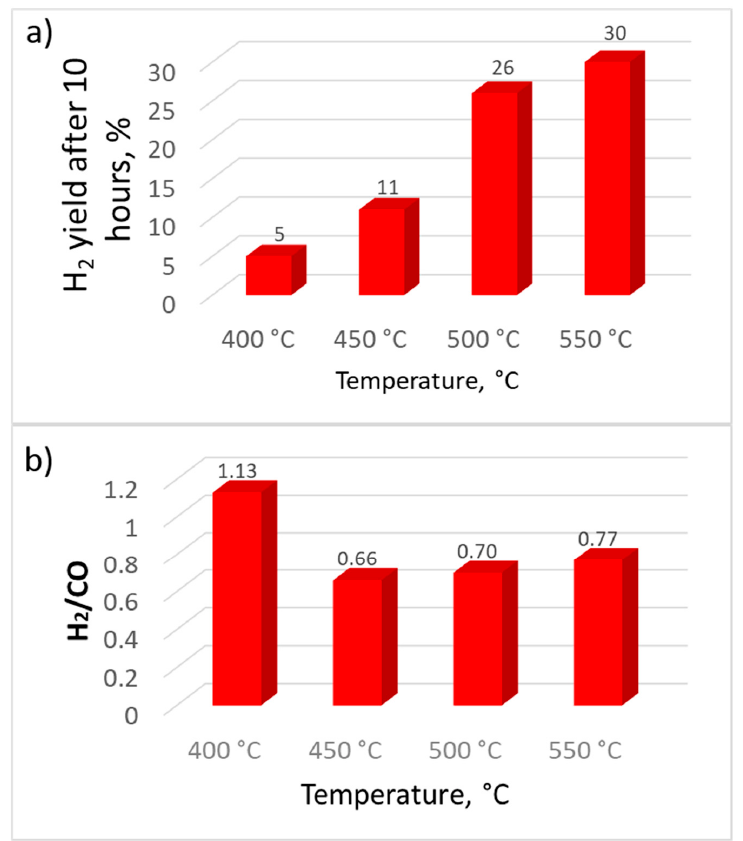
Figure 3. H 2 yield ( a ) and H 2 /CO ratio after 10 h of reaction ( b ) for Ni/Ce catalyst at different